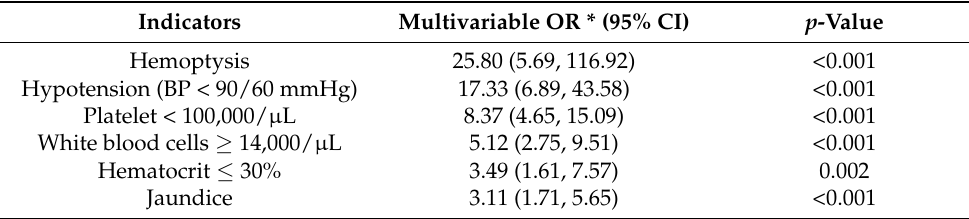
Table 3. Multivariable odds ratios (OR) and 95% confidence interval (CI) for Leptospirosis infection severity. Indicators Multivariable OR * (95% CI) Hemoptysis